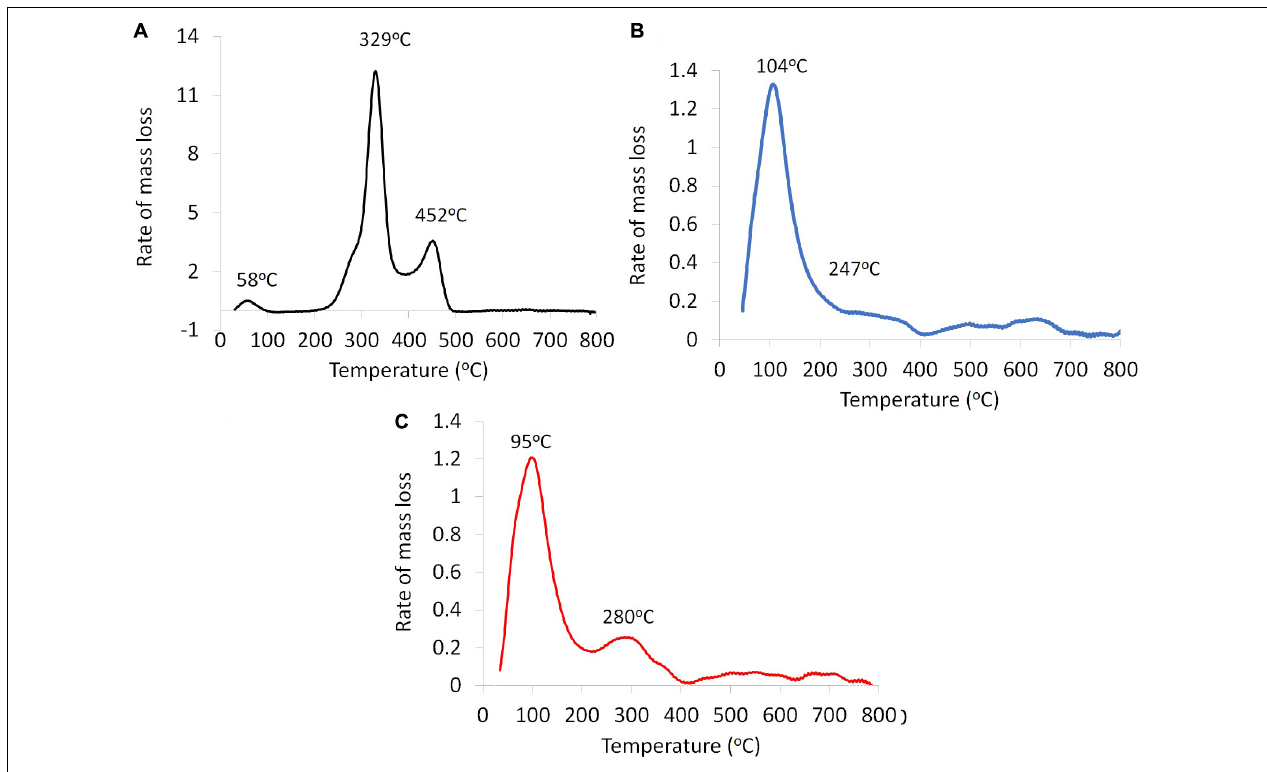
FIGURE 6 | TGA analysis of jute fibers (A) , geopolymer matrix (B) , and geopolymer composite (C) .